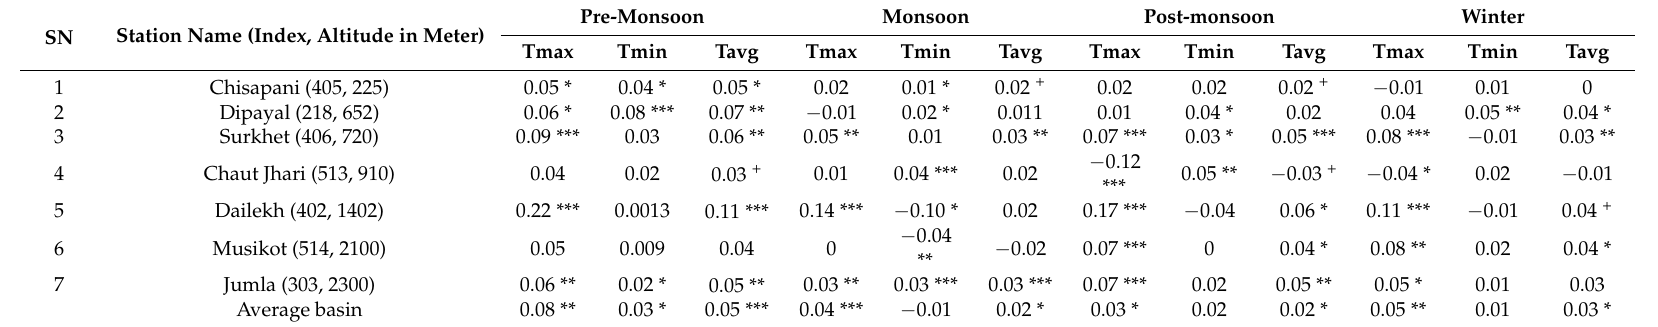
Table 2. Temperature trend ( ◦ C/year) in different elevations of the